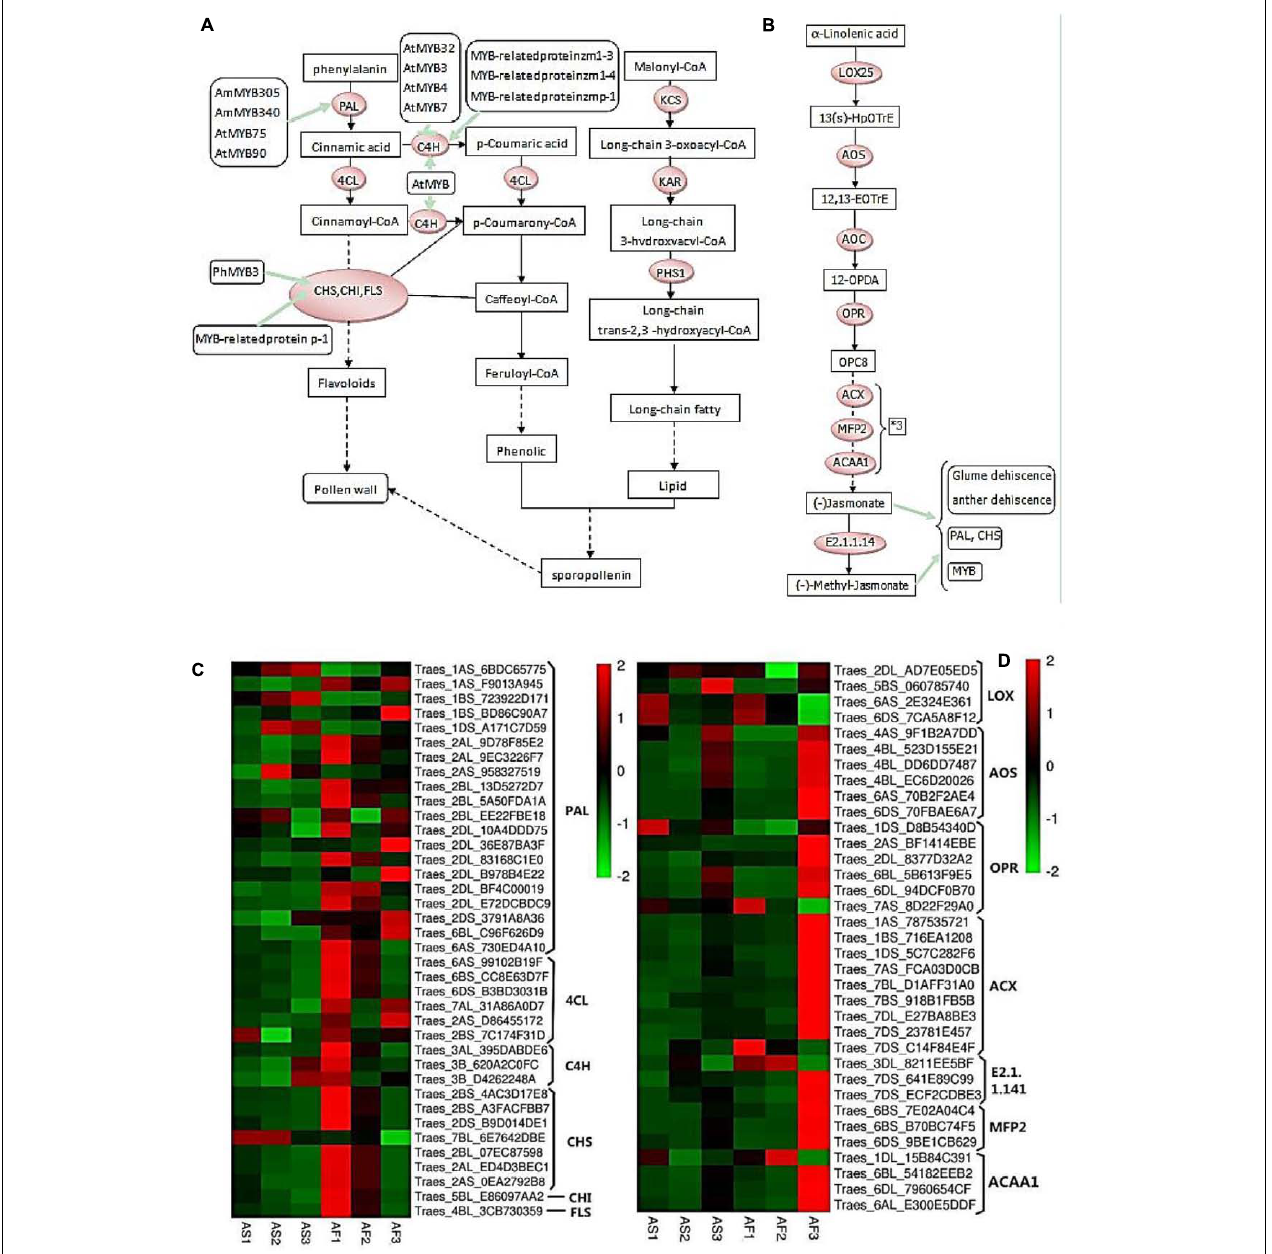
FIGURE 9 | Phenylpropanoid and jasmonic biosynthetic pathways, and hierarchical clustering of genes encoding related enzymes. (A) R2R3-MYB transcription factors that regulate the phenylpropanoid biosynthetic pathway in the tapetum and their relationships with pollen wall formation. (B) Jasmonate biosynthetic pathway. (C) Hierarchical clustering of related genes in the phenylpropanoid biosynthetic pathway. (D) Hierarchical clustering of related genes in the jasmonate biosynthetic